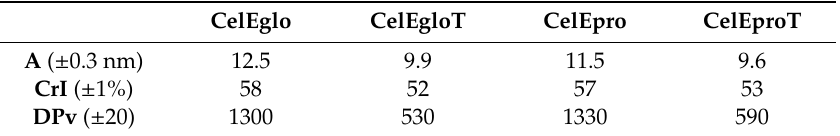
Table 3. Crystallinity of the isolated cellulose from Eucalyptus woods assessed by solid-state 13 C NMR, degree of polymerization (DPv) determined by viscosimetry.